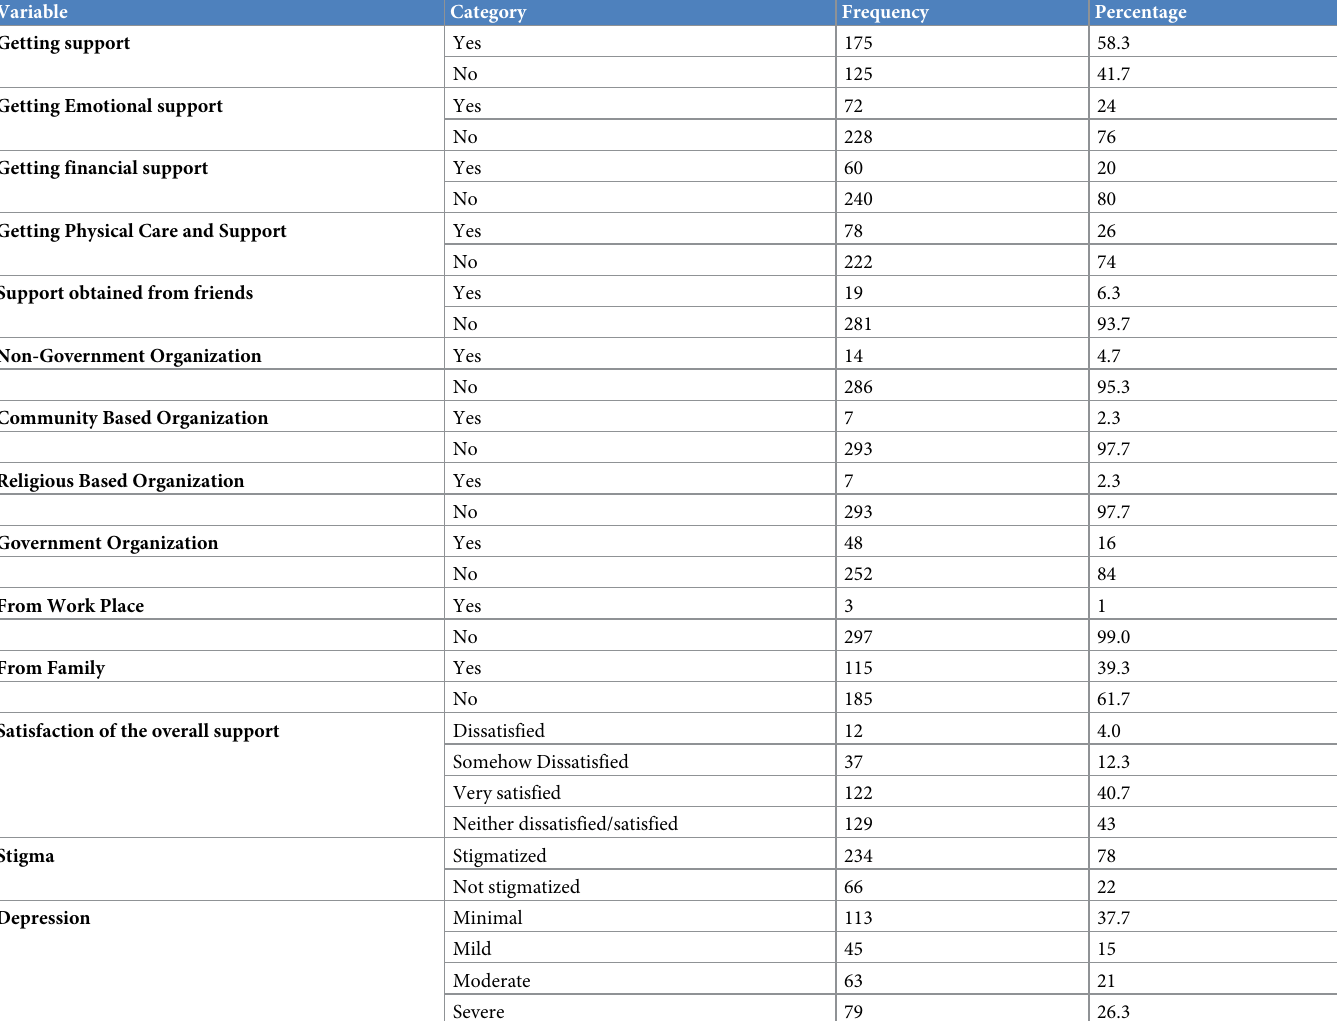
Table 3. Psychosocial characteristics of respondents on quality of life among PLHIV in Jimma zone public hospitals, South-west Ethiopia.